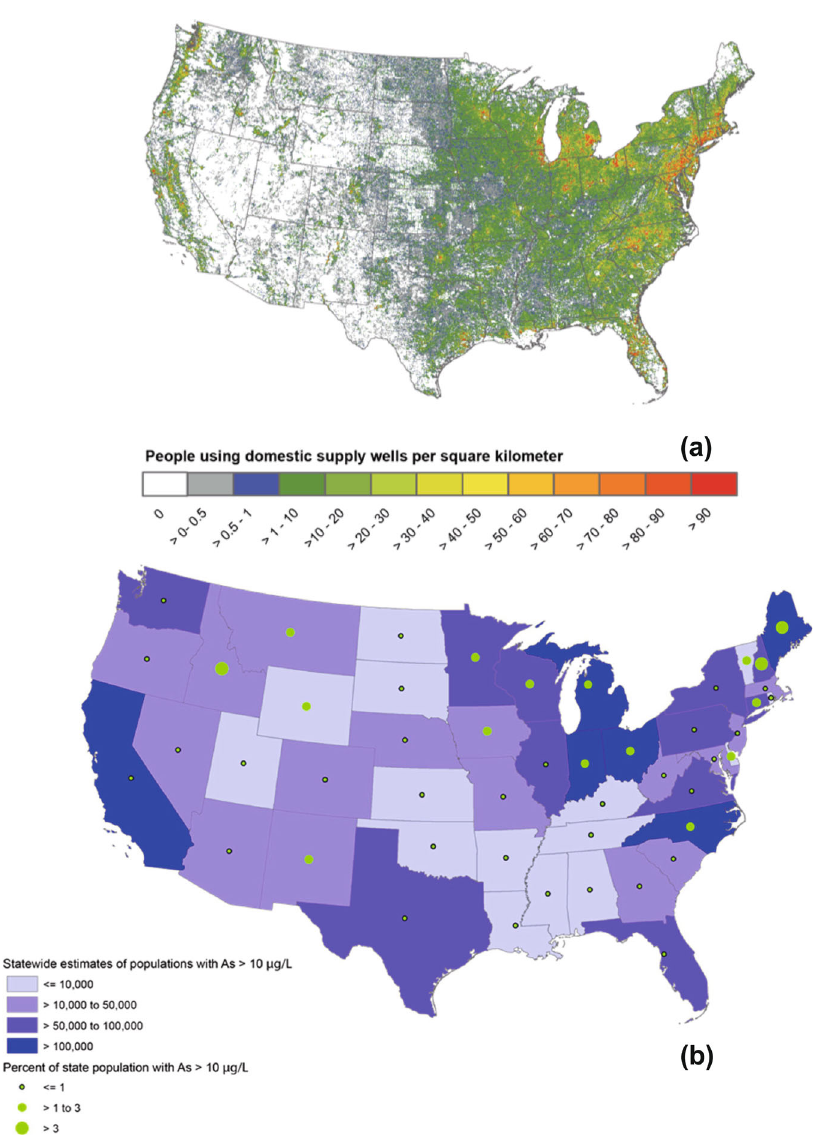
Fig. 3 Distribution of the population using domestic wells. a Population using domestic wells, and b domestic wells affected by arsenic. Over 43 million people, 15% of the U.S. population, rely on domestic (private) wells as their source of drinking water. About 2.1 million people in the conterminous U.S. were using water from private wells with predicted arsenic concentration >10 μ g/L (reprinted with permissions from 35,36 ; Copyright © Elsevier, 2017; Copyright © ACS,